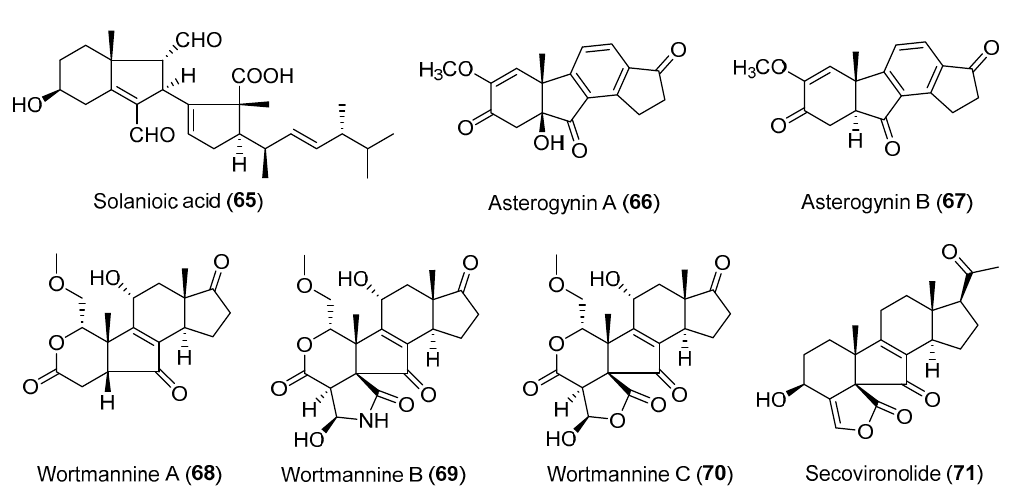
Figure 12. Structures of compounds 65 – 71 .